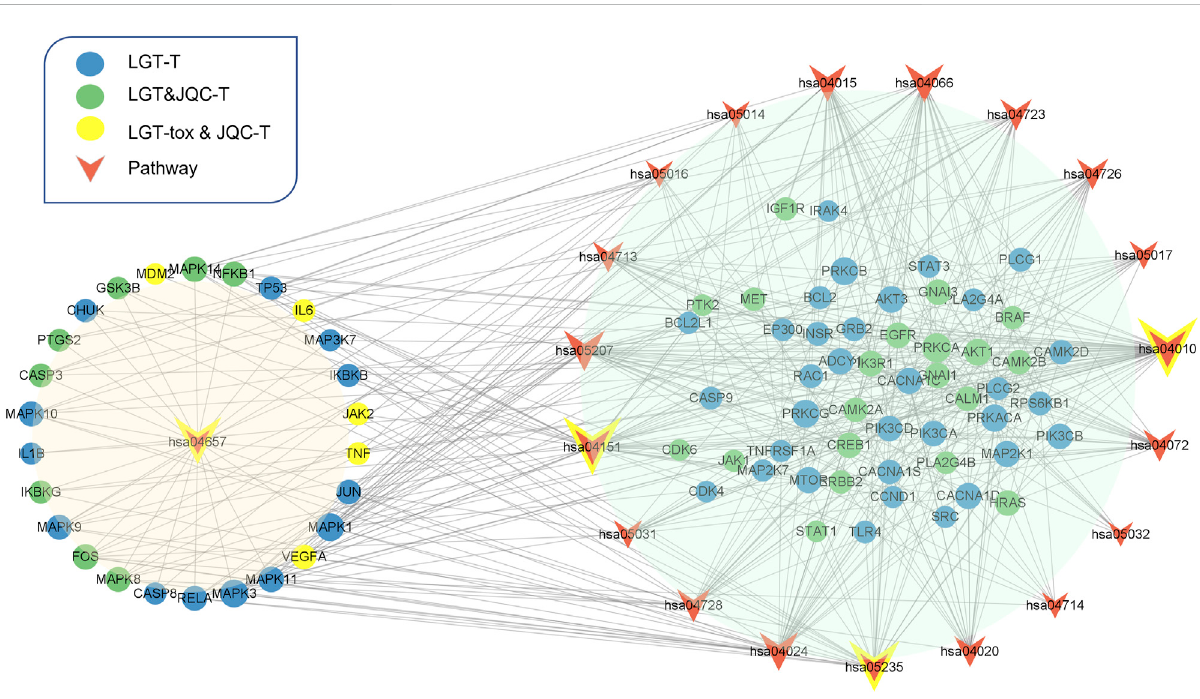
FIGURE 8 Target-pathway network of LGT-JQC. The greennodes are the common targets of LGT and JQC, and the blue represents the LGT targets, the yellow nodes are the common targets of LGT-tox and JQC, the red represents the pathways. The orange area represents the tox-related pathway, the green area represents the synergism -related